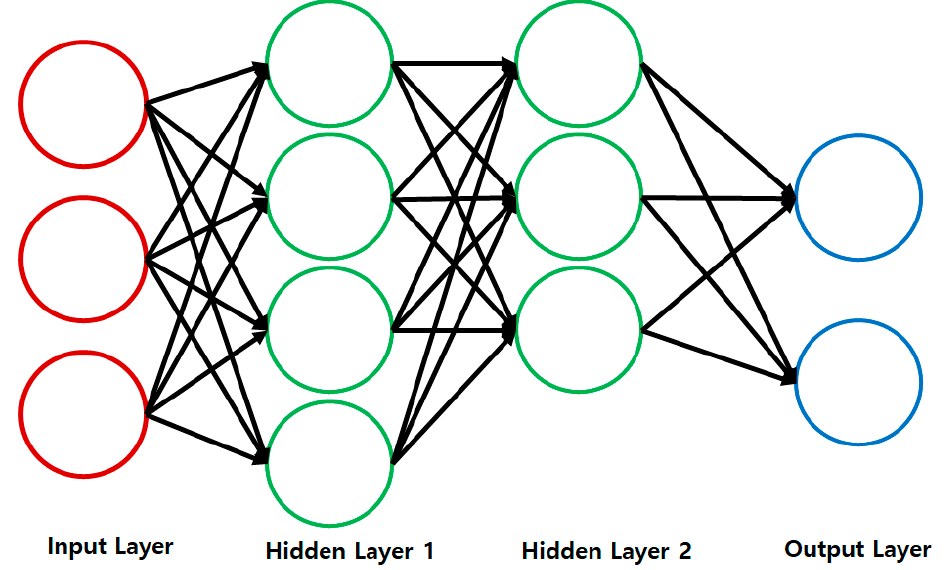
Figure 5. A model of artificial neural networks (ANNs).